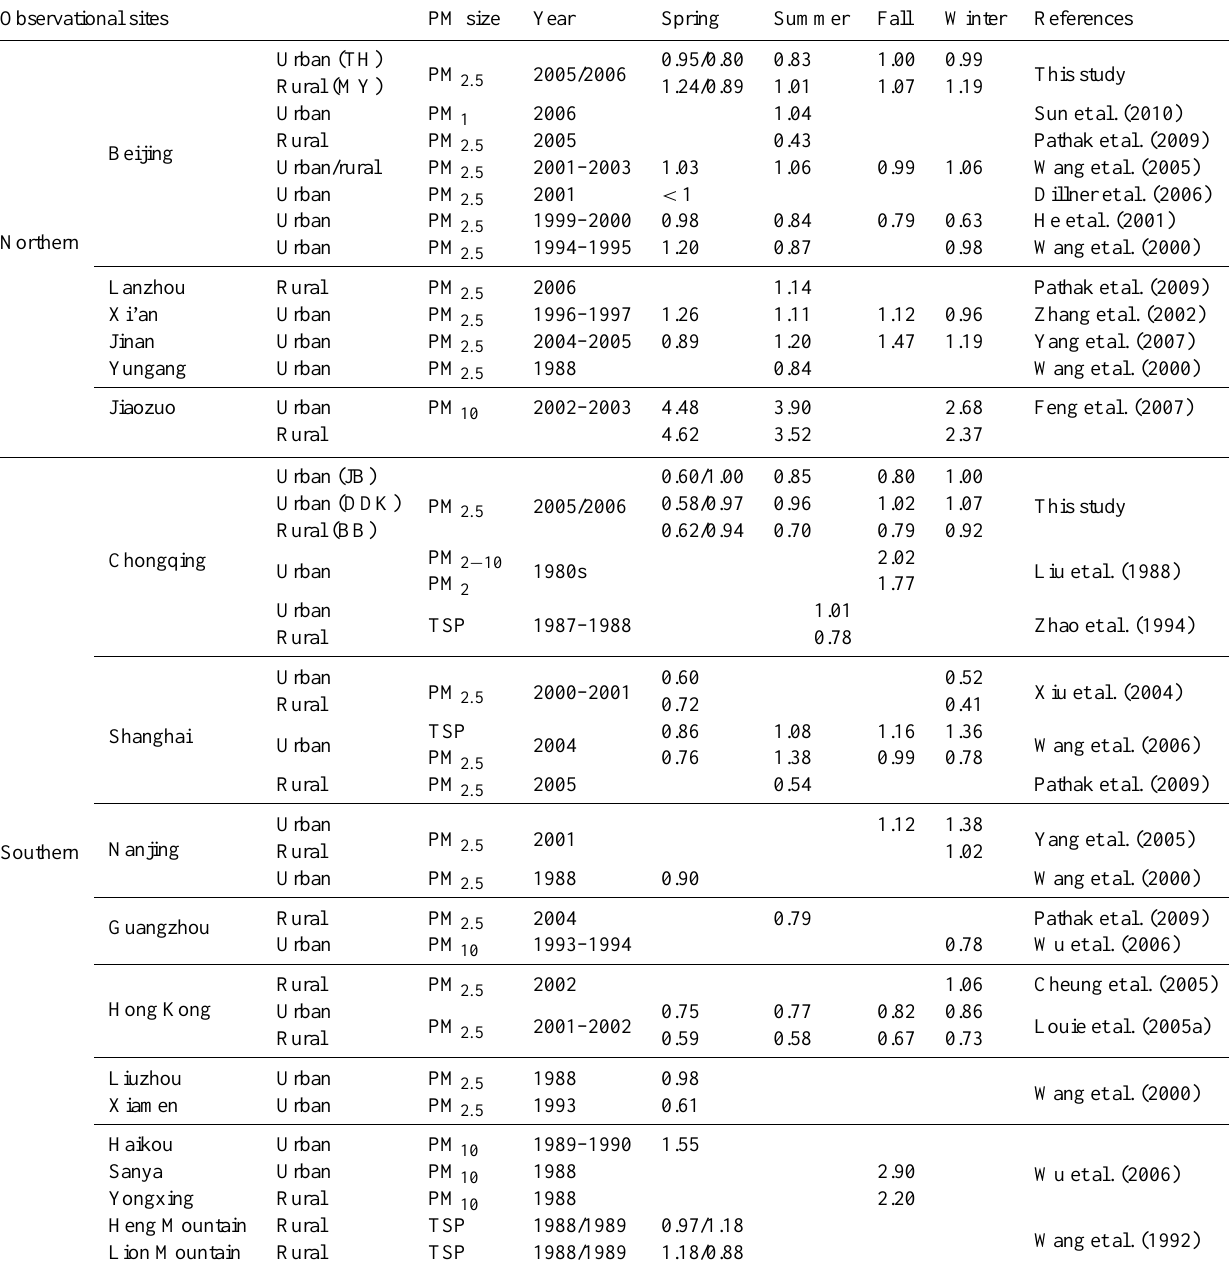
Table 2. Seasonal R C / A at multiple sites in the northern and southern China (R C / A = (NH + MAM, summer = JJA, fall = SON, winter =